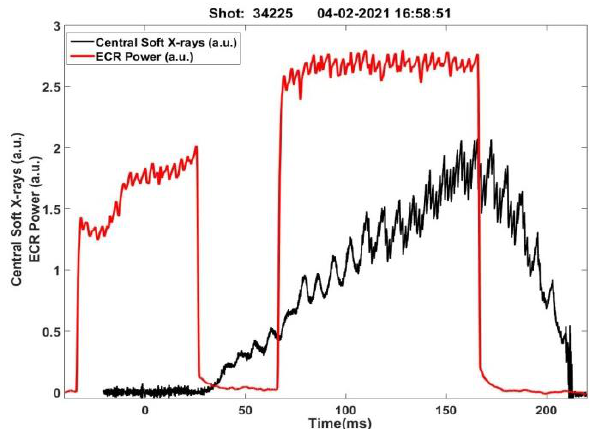
Fig. 3. Soft X-ray signal and ECRH in Aditya-U